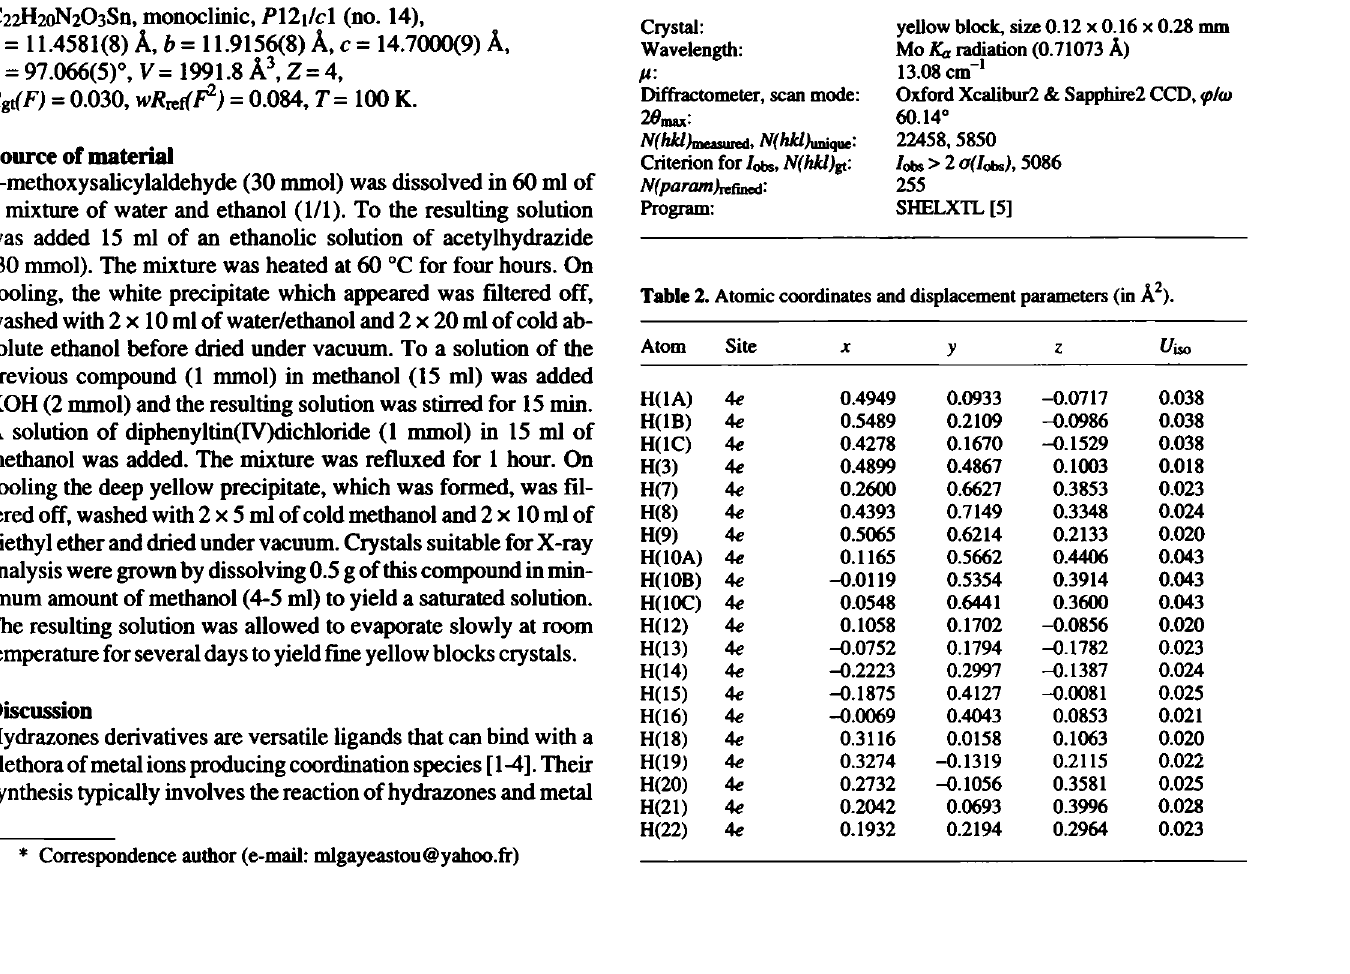
Table 1. Data collection and handling.